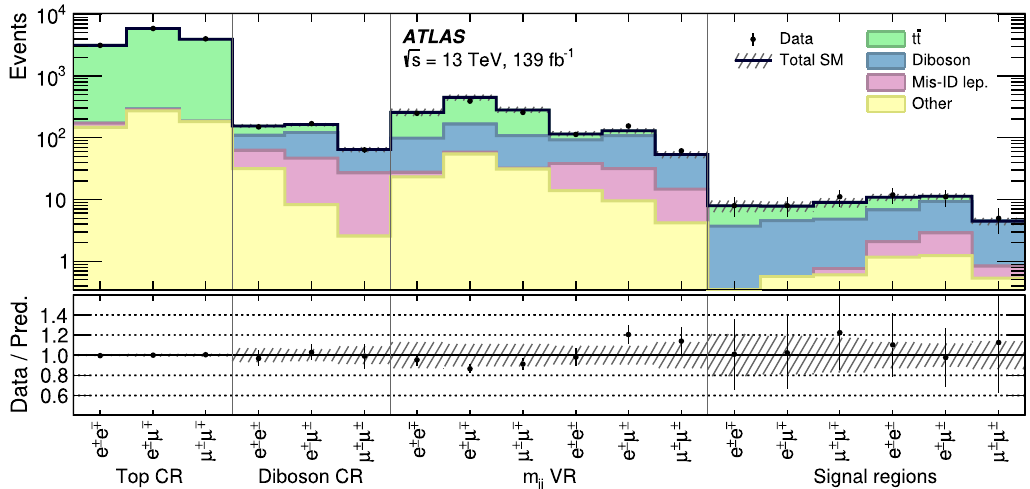
Fig. 5 The numbers of observed and expected events in the control, validation,andsignalregionsforallchannels,splitbyleptonflavourand electricchargecombination.Thebackgroundexpectationistheresultof thebackground-onlyfitdescribedinthetext.Thehatchedbandsinclude